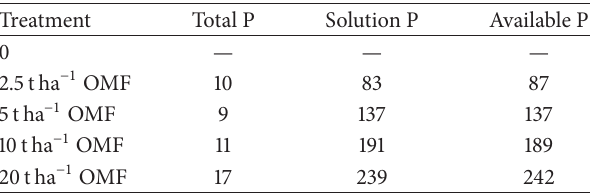
Table 2: Percentage increase in forms of phosphorus.